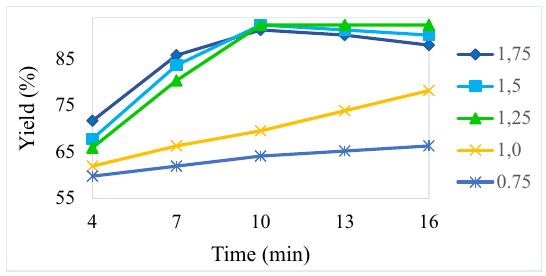
Figure 4: E ff ect of molar ratio of acetic anhydride/epoxy on the CES yield in surveying time of 4 –